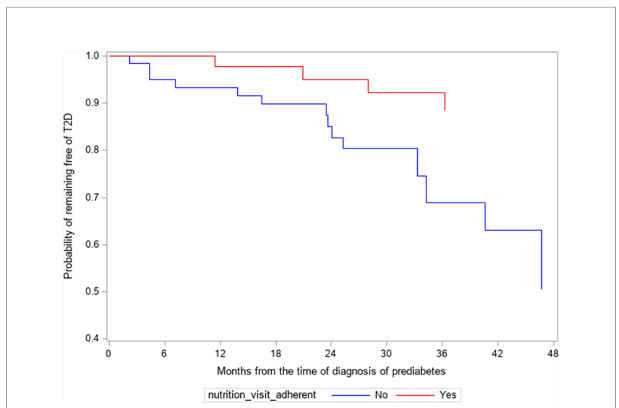
FIGURE 1 | Kaplan-Meier survival analysis of the progression from prediabetes to type 2 diabetes (T2D). Hazard ratio of progressing to T2D for non-adherent subjects versus adherent subjects was 3.88 (95% CL 1.26- 11.98, p=0.02). hazard ratio of progression to T2D from prediabetes for the non- adherent subjects versus adherent subjects was 3.88 (95% CI 1.26 to 11.98, p=0.02).